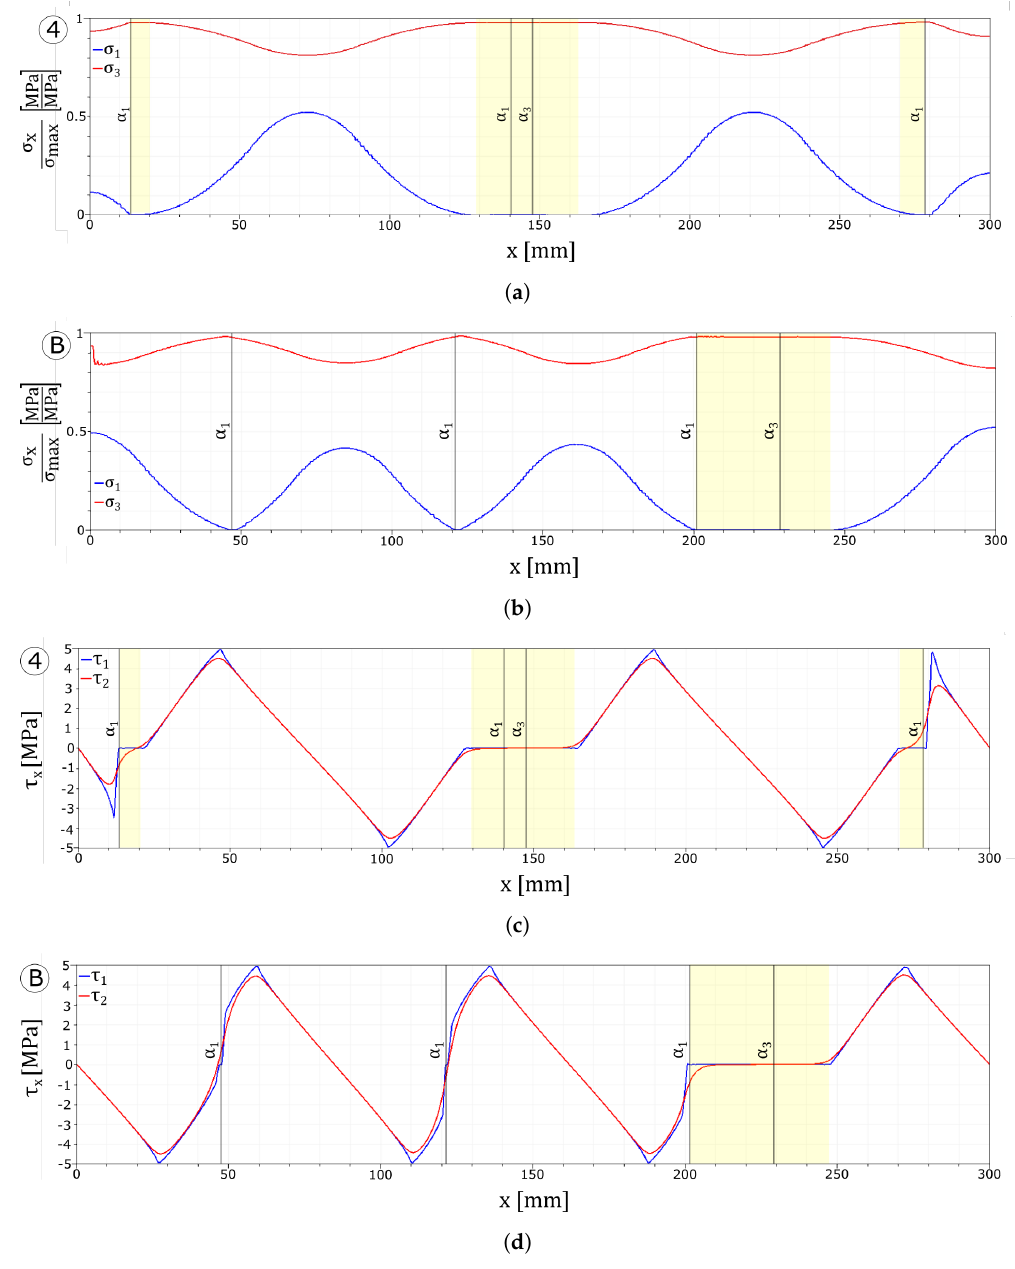
Figure 8. Numerical results: stress plots. ( a ) UD m9 glass plies stress profiles. ( b ) UD m52 glass plies stress profiles. ( c ) UD m9 interface stress profiles. ( d ) UD m52 interface stress